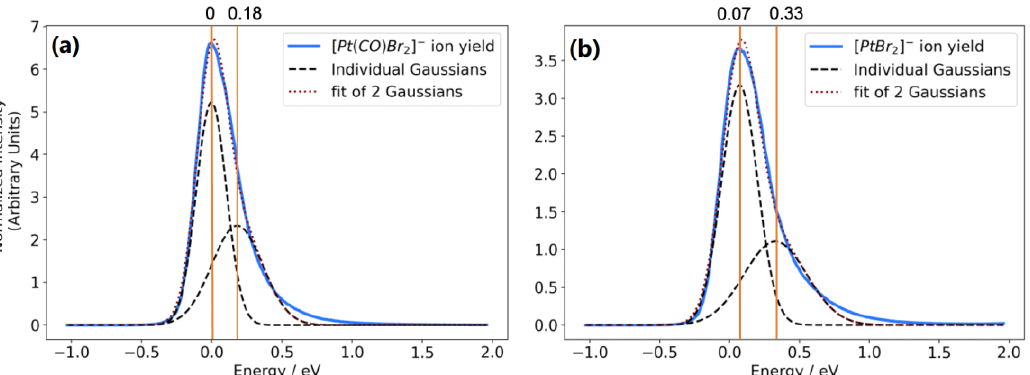
Figure 4. Fit of two Gaussian functions to the [Pt(CO)Br 2 ] − ion yield ( a ) and the [PtBr 2 ] − ion yield ( b ). The first represents contributions from dissociation from the anionic ground state, while the latter represents these from the first excited anionic state.